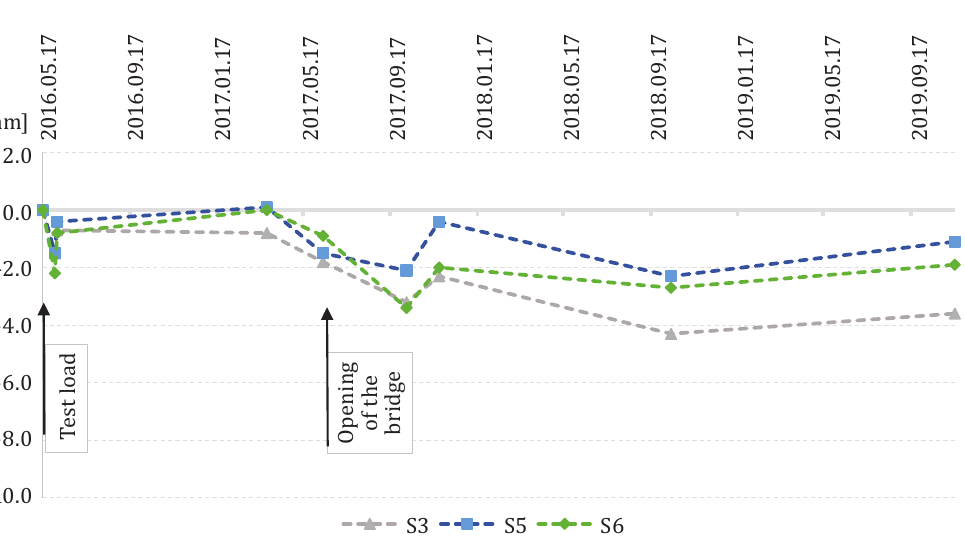
Figure 10. Horizontal displacements (in mm) of control points S3, S5, S6 within 3.5 years from starting test